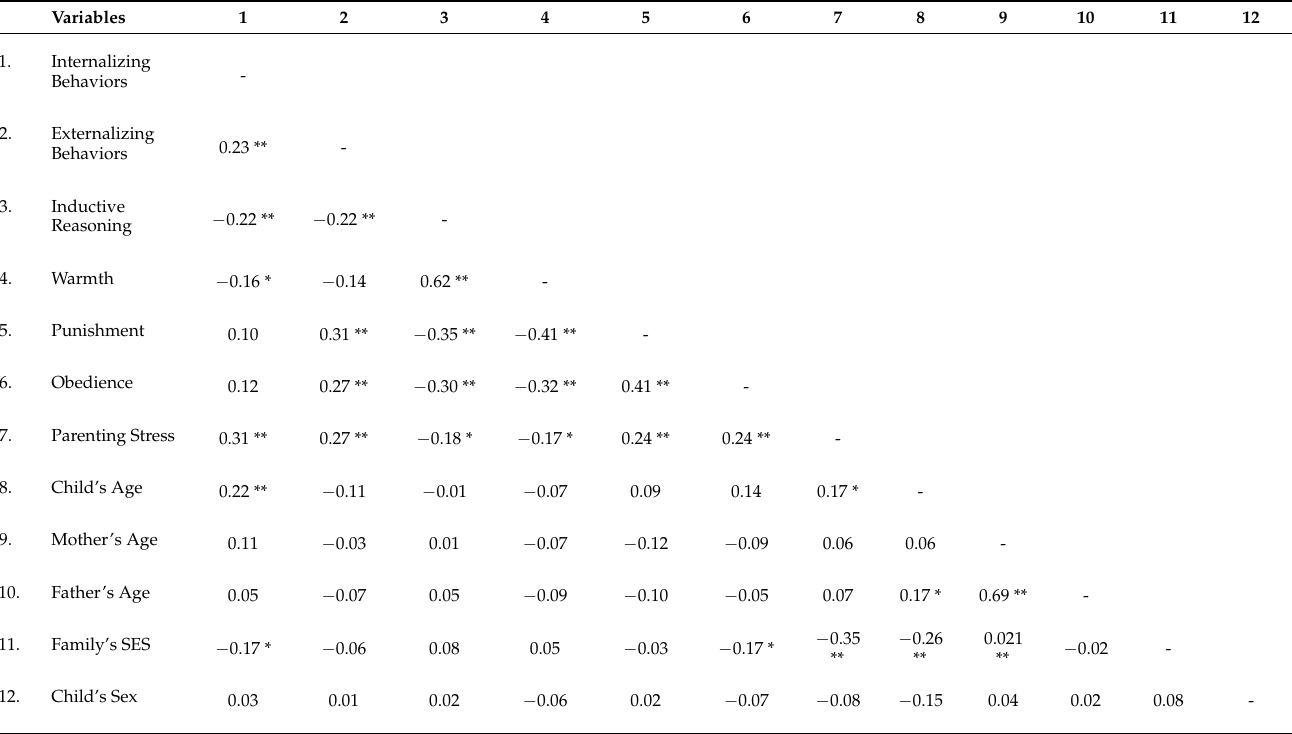
Table 1. Bivariate Correlations and Descriptive Statistics for the Study